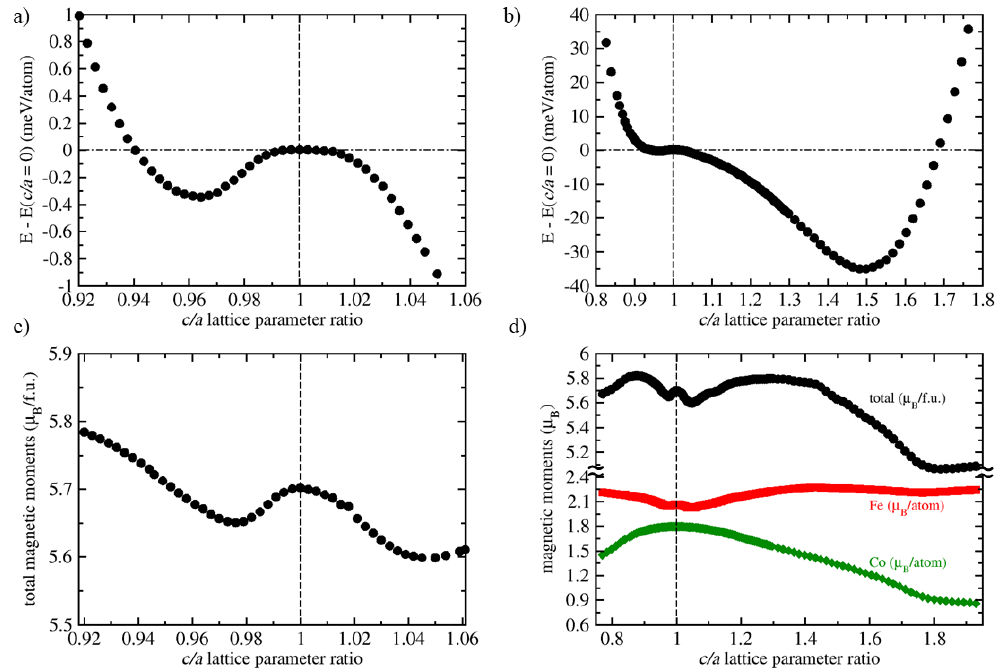
Figure 6. Computed energies and magnetic moments of the full Heusler polymorph of Fe 2 AlCo transformed along the Bain’s path: ( a ) energies close to the undeformed state ( c / a = 1) with a shallow minimum, ( b ) energies for a broader range of c / a values with a deeper minimum, ( c ) total magnetic moment per formula unit for states close to the undeformed state, ( d ) total magnetic moment and local magnetic moments of Fe and Co atoms for a broader range of c / a values. The energies in subfigures ( a,b ) are depicted with respect to the energy of undeformed state with c / a = 1 (indicated by vertical dashed lines and horizontal dash-dot lines). Mind the interruption of the vertical axes in part ( d